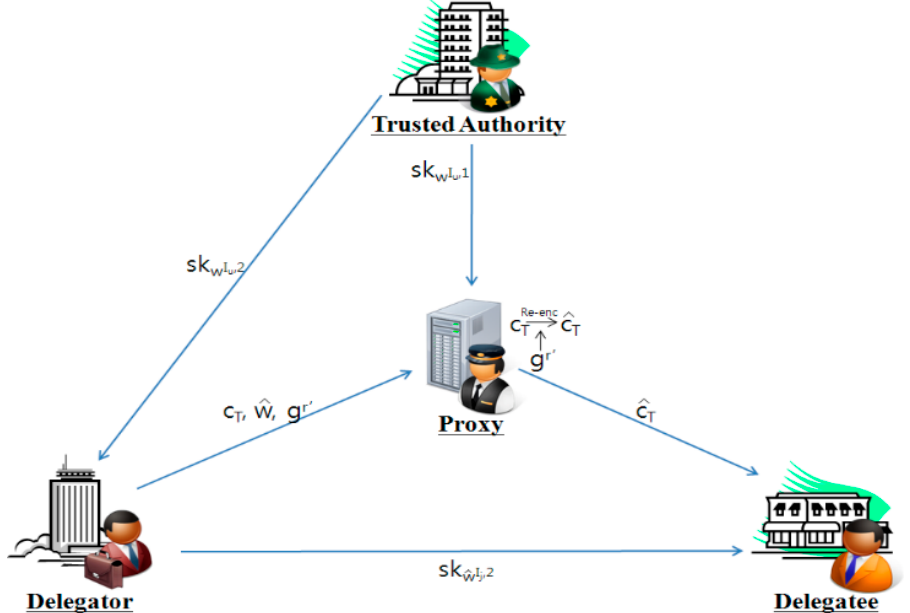
Figure 7. The concept of CP-ABTD.